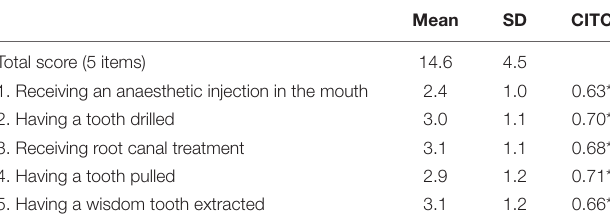
TABLE 2 | Mean scores (SD) and corrected item-total correlations (CITC) for each s-FDPQ